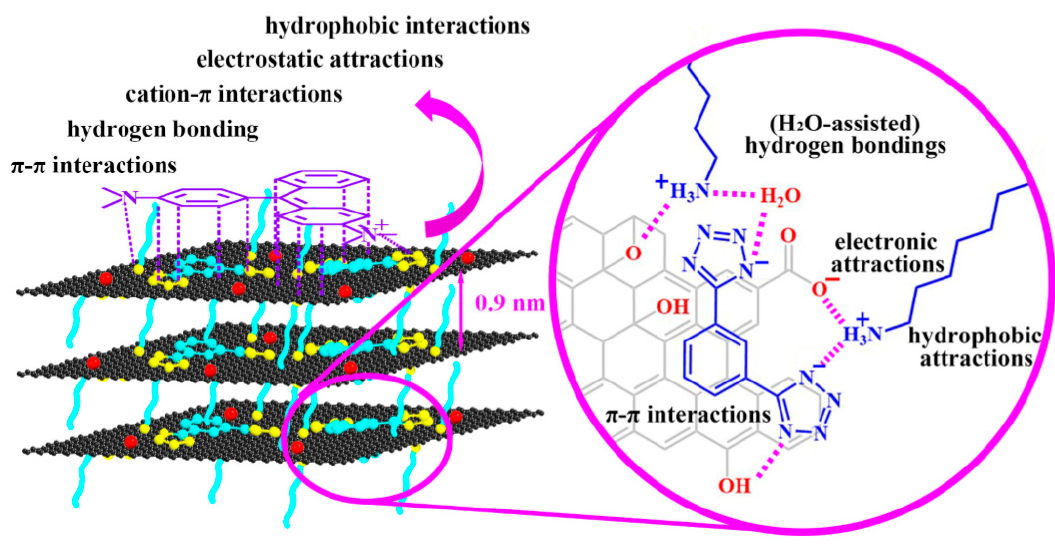
Figure 4. Schematic representation of the non-covalent interactions between graphene oxide, 1-OA, and malachite green (MG). Reproduced from [64], with permission from Elsevier, 2018.